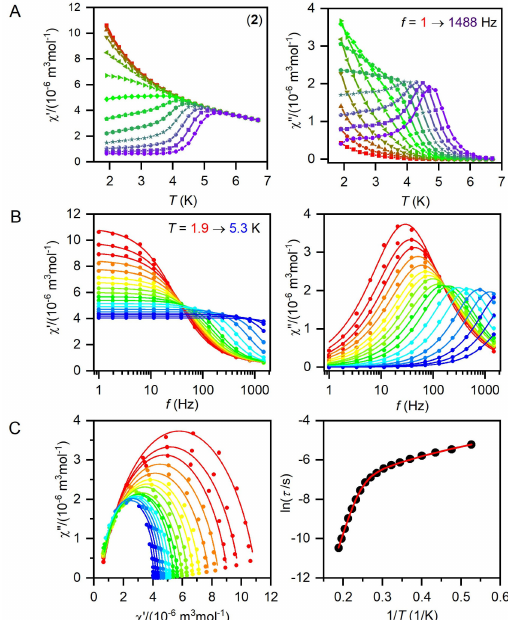
Figure 4. AC susceptibility data for 2. A : in-phase χ (cid:48) and out-of-phase χ (cid:48)(cid:48) molar susceptibilities at the applied external magnetic field B DC = 0.1 T (full lines are only guides for eyes). B :